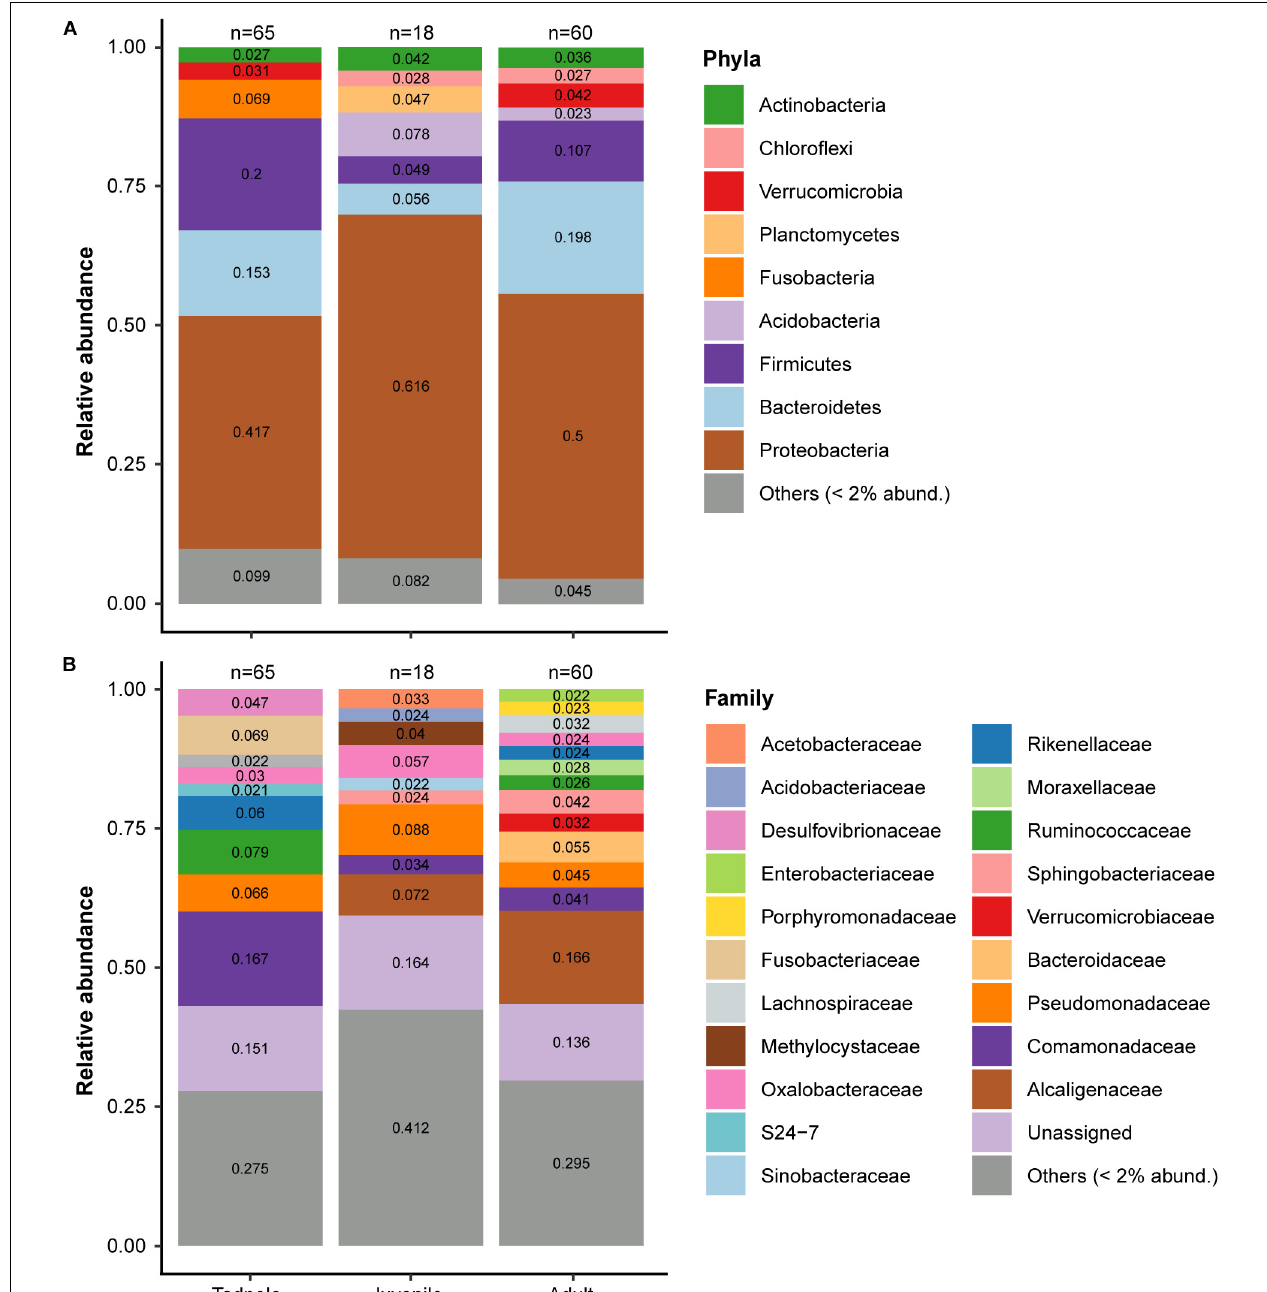
FIGURE 3 | Skin microbiome of L. vibicarius across life stages. (A) Relative abundance of skin bacterial taxa at the phylum level. Rare ASVs (relative abundances < 2%) were clustered together. (B) Relative abundance of skin bacterial taxa at the family level. ASVs with relative abundances < 2% were clustered together. Only Bd – individuals are